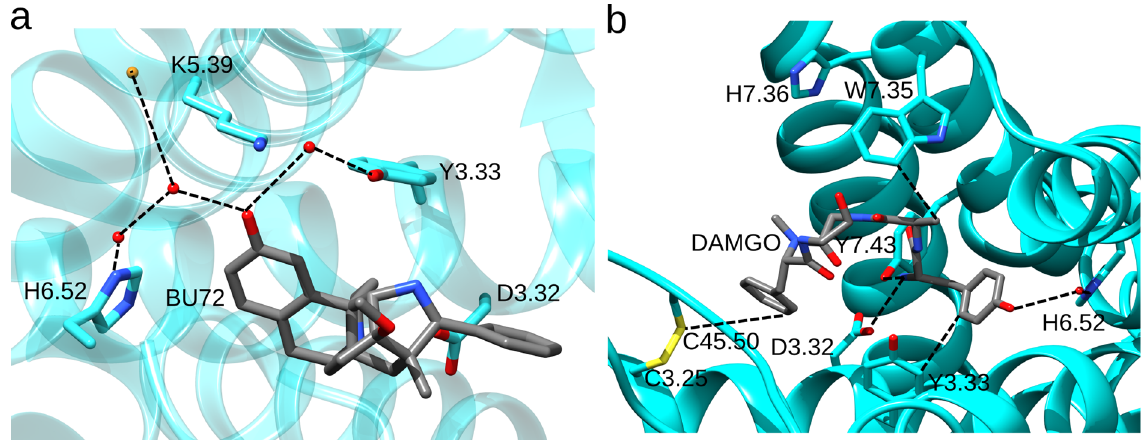
Figure 4. Ligand-protein interactions in static structures of the MOR. ( a ) Water-mediated H-bond network of H6.52 in the structure of BU72-bound MOR. The agonist BU72 H-bonds to H6.52 via two waters. The H-bond network includes K5.39 and Y3.33. D3.32 is close to the ligand. The molecular graphics is based on structure PDB ID:5C1M [32]. ( b ) Binding site interactions of DAMGO. Protein groups shown have at least one side chain atom within 4 Å of DAMGO. The closest atoms between DAMGO and MOR groups shown are connected with dotted lines. Molecular graphics based on PDB ID:6DDF [34] were prepared using UCSF Chimera 1.14 [23] and the text and dotted lines were added with Inkscape 1.0,